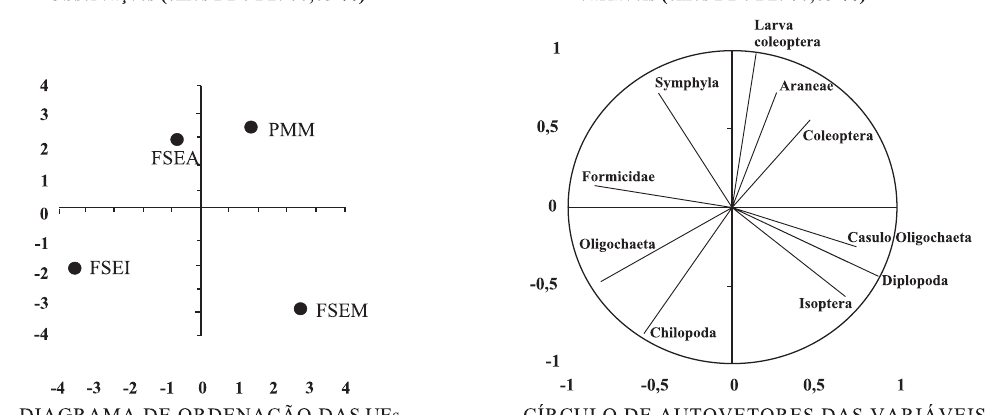
Figura 8. Análise de componentes principais da macrofauna invertebrada do solo sob as diferentes unidades de estudo (UEs) para o período